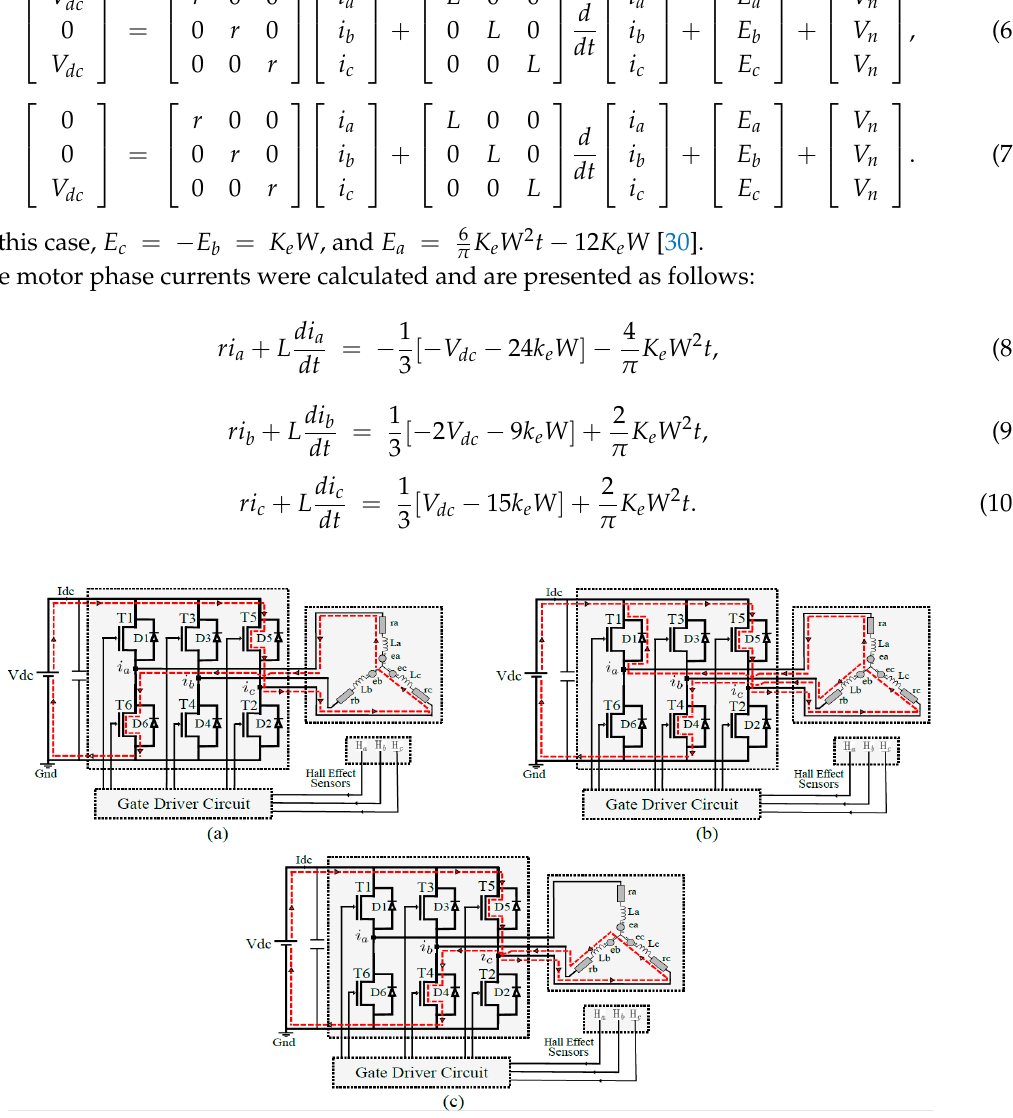
Figure 4. MOSFET states for lower-bridge current commutation: ( a ) Before the commutation interval, ( b ) during the commutation interval, and ( c ) after the commutation interval.